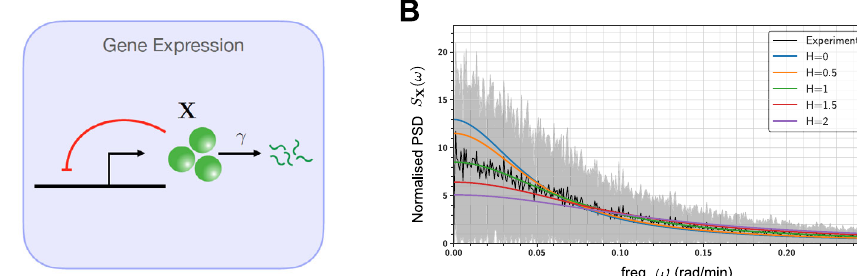
Fig. 6 PSD-based inference of a self-regulatory gene expression model. A Depicts the self-regulatory gene expression system where the output represses the gene (shown in red) via a nonlinear Hill function (45) with cooperativity coef fi cient H . B Plots the normalised PSDs (area under the PSD curve is 1) obtained by Padé PSD for various values of H , and compares it with the normalised PSD obtained from experimental single-cell trajectories. The experimental PSD was computed by averaging the PSDs from Q = 100 single-cell trajectories, and the black curve represents the mean, while the shaded grey region represents the symmetric one standard deviation interval around the